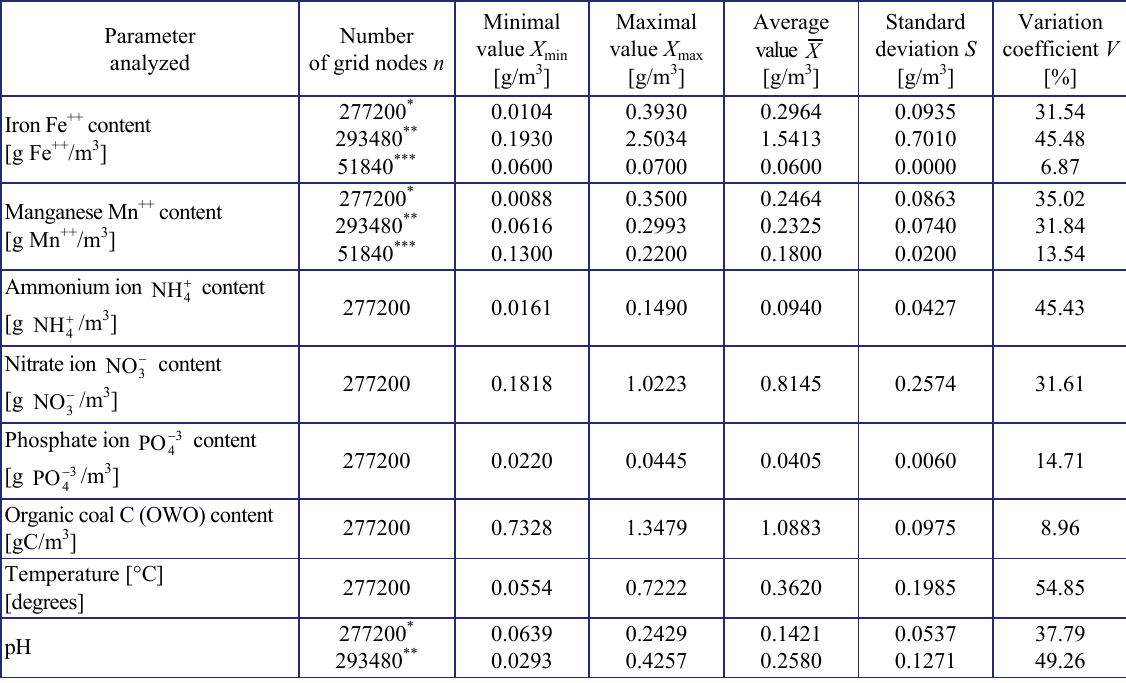
Table 11. Global statistics of estimation standard deviation σ k of quality parameters of underground